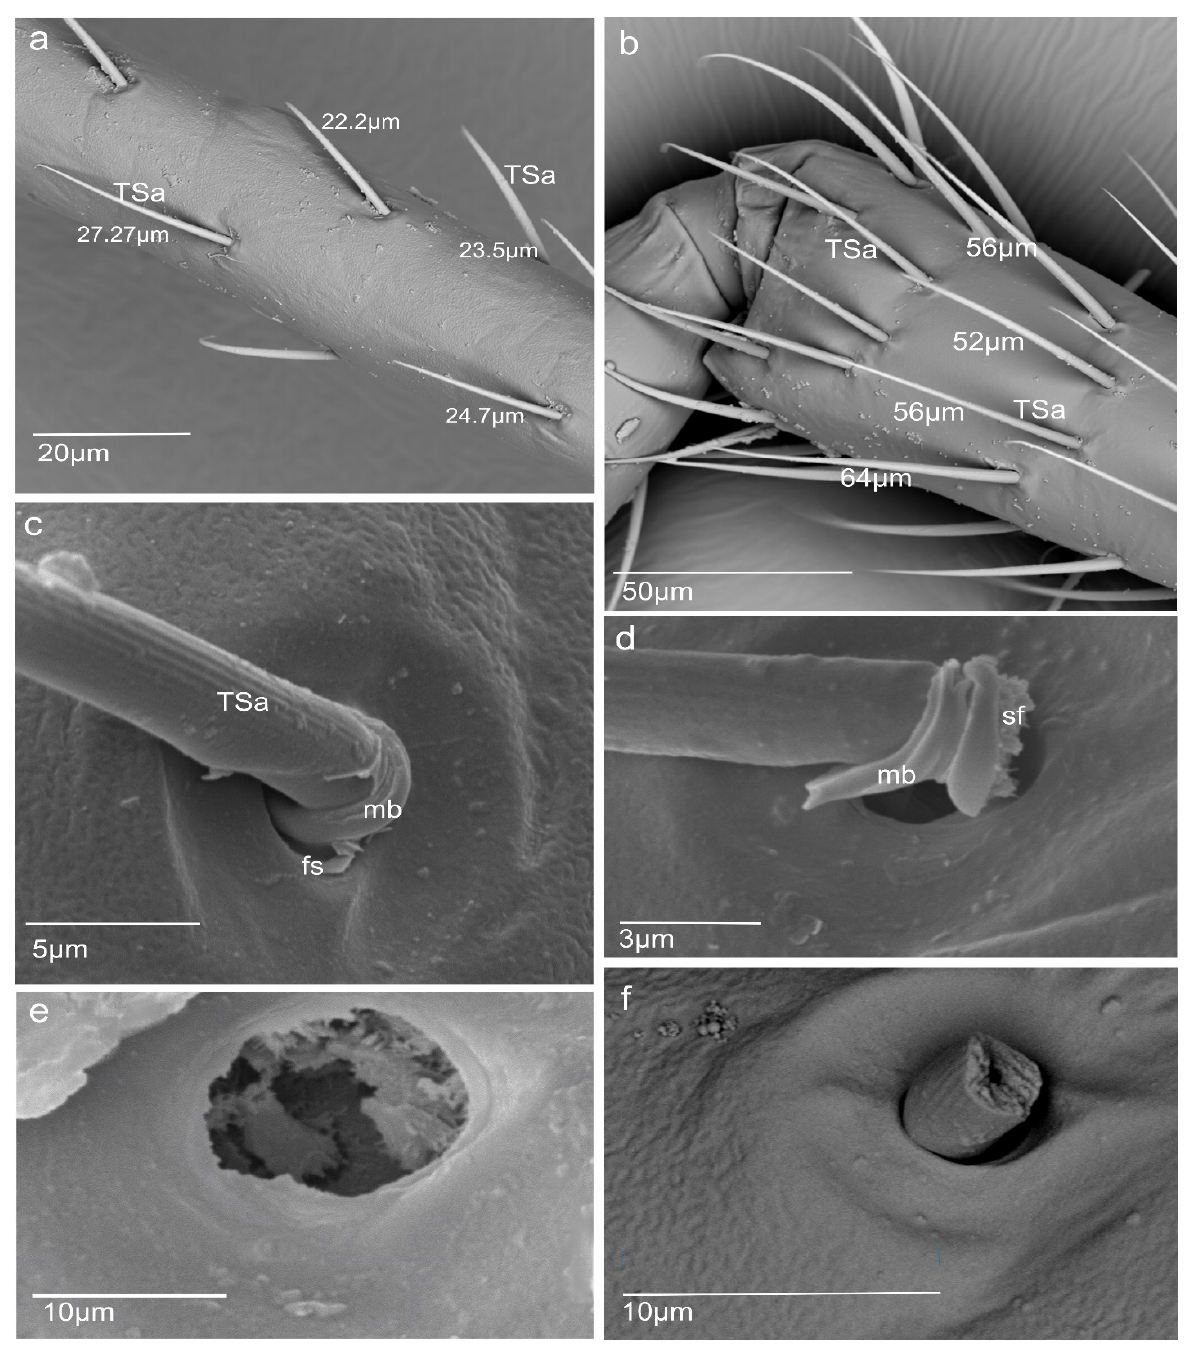
Figure 3. Different length of Sensilla (TSa) and shape of the flexible socket (fs) and ( a ) arrangement of the trichoid sensilla in the proximal and medium part of the pedicel; ( b ) arrangement of the trichoid sensilla in the distal part of the pedicel; ( c ) position of the sensilla embedded in the socket on the surface of the pedicel; ( d ) base part of sensillum with the membrane after removing it from the socket, when suspension fibre (sf) is visible; ( e ) size of the lumen after removing of the sensillum; ( f ) broken sensillum and diameter of the stem of the sensillum near its base.